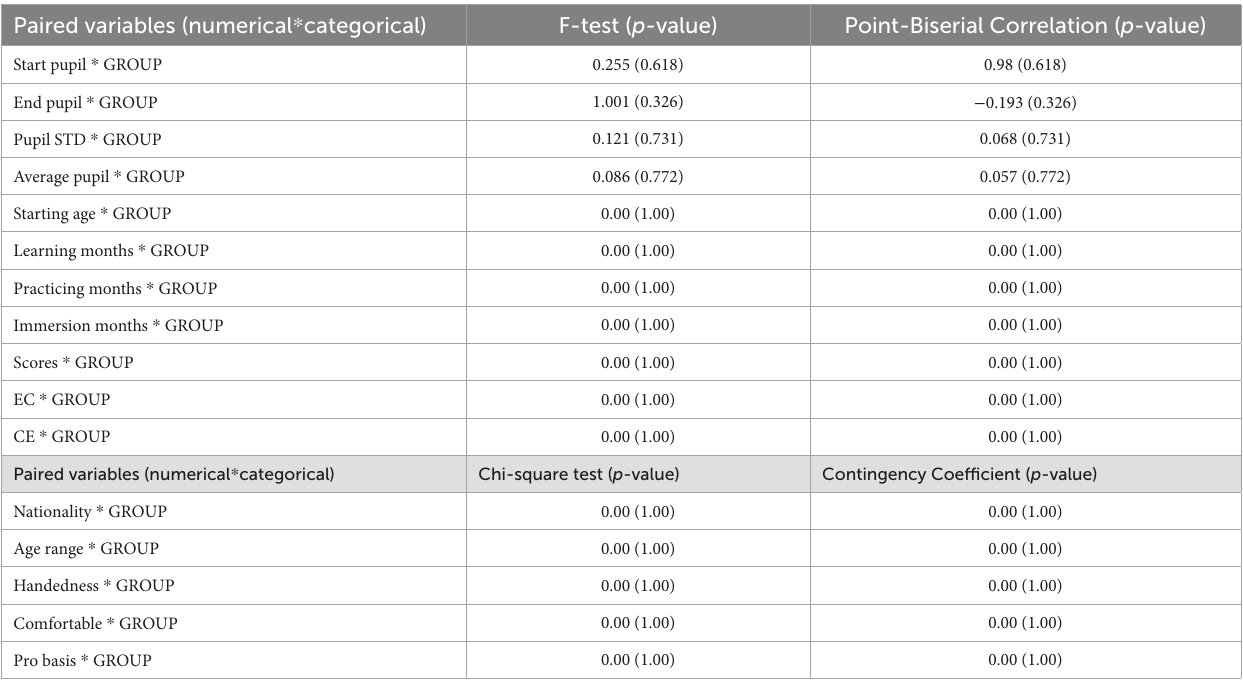
TABLE 2 Correlation